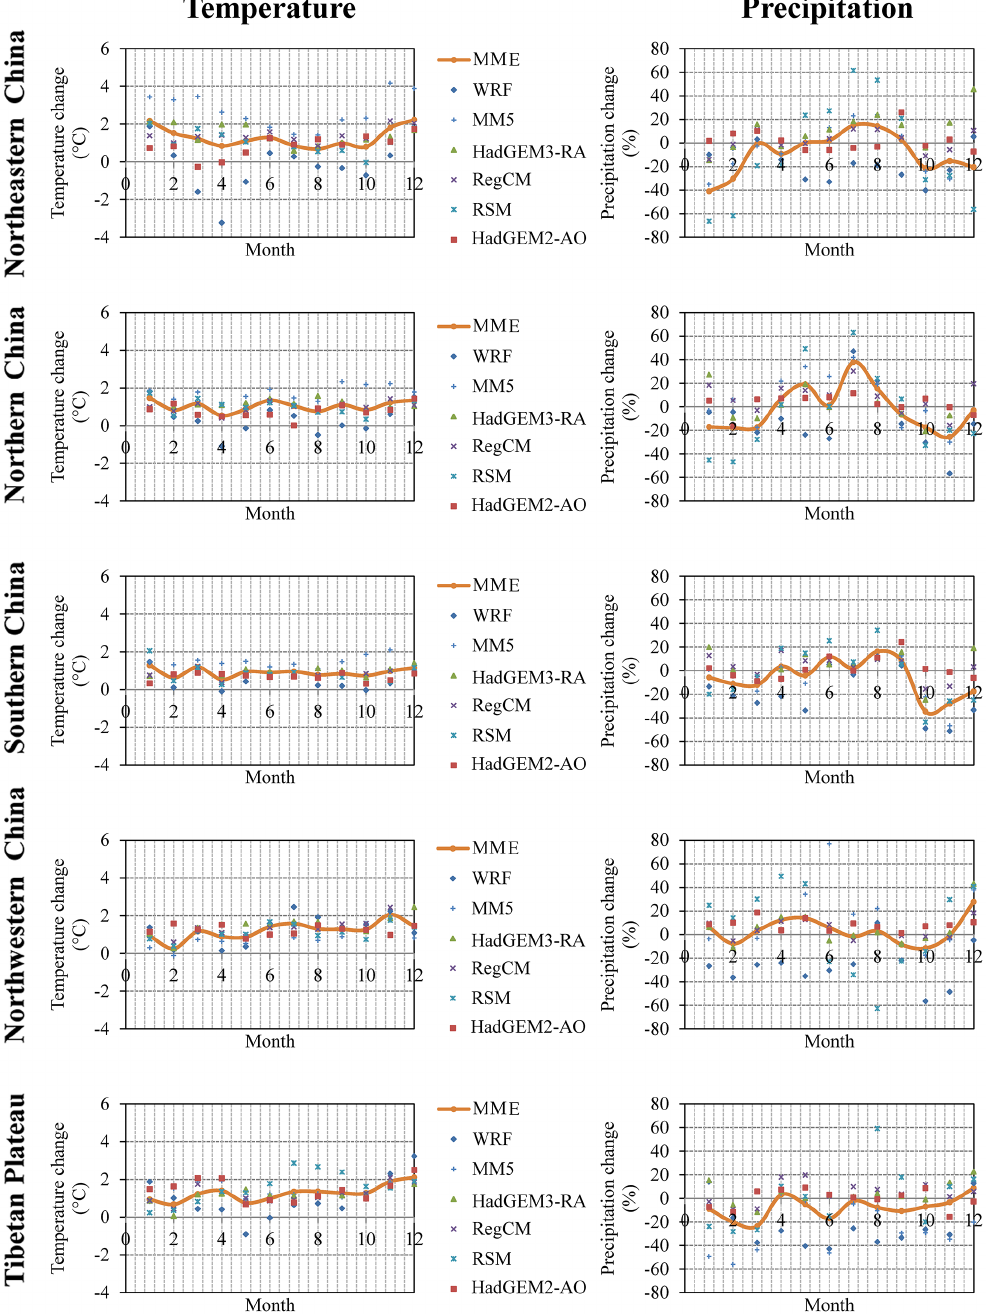
Figure 9. Projected future changes in monthly mean temperature and precipitation by the forcing GCM HadGEM2-AO, the MME, and each of the five RCMs under the RCP4.5